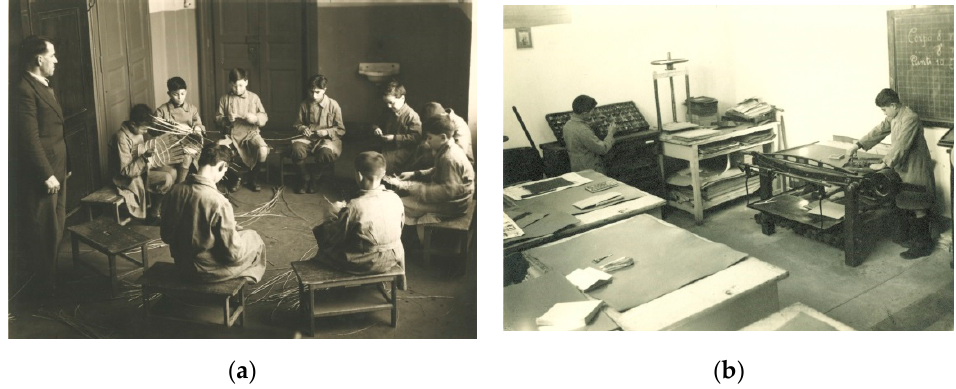
Figure 4. ( a ) Basket maker labs (ASPG, file 3492); ( b ) Typography labs (ASPG, file